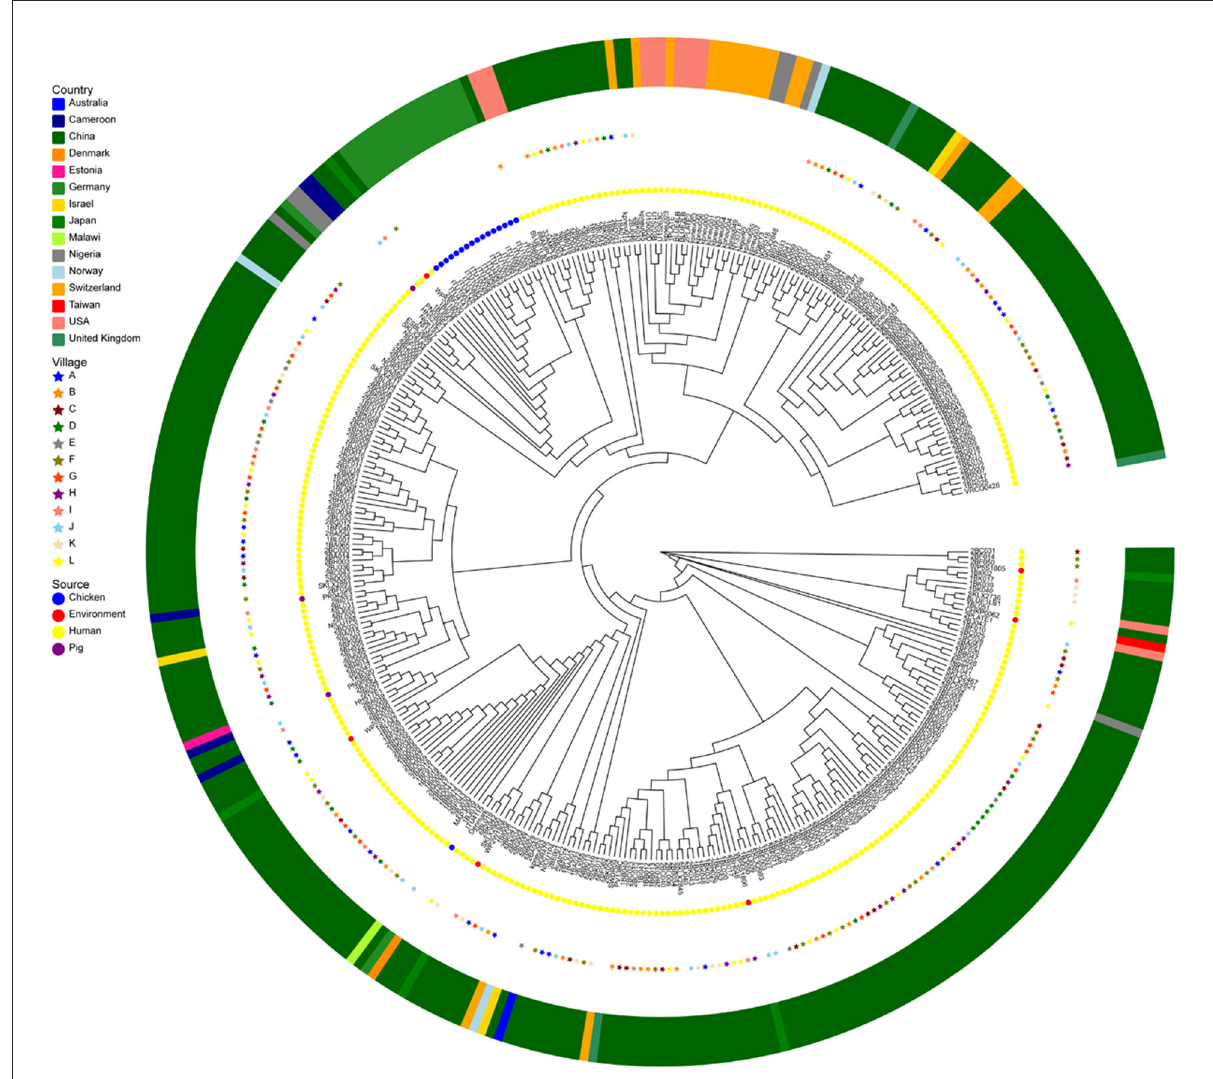
FIGURE6 Genomic analysis of ESBLs-producing K. pneumoniae ( n = 264) of this study and K. pneumoniae (n = 91) from various regions of the world ( n = 91). A maximum-likelihood phylogenetic tree was constructed using genome-wide single-nucleotide polymorphism (SNP) analysis. Sources of the isolates are indicated by different colors for location (asterisks or squares) and samples’ origin (circles). This core-genome-based maximum-likelihood tree was visualized ignoring information in gene-tree branch lengths for the convenience of